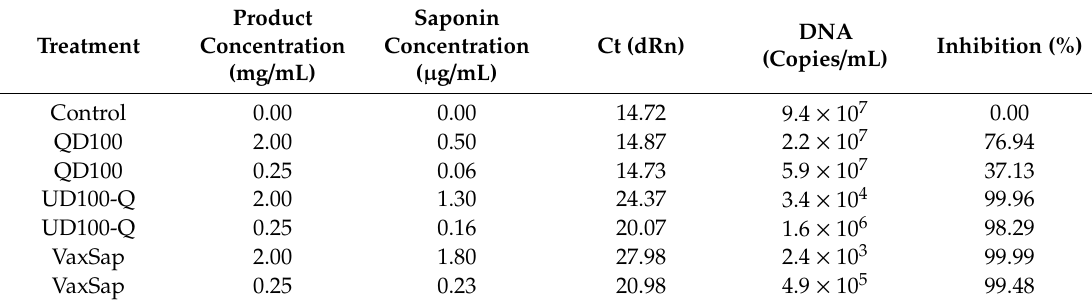
Table 2. In vitro e ffi cacy of quillaja extracts in cells against P.